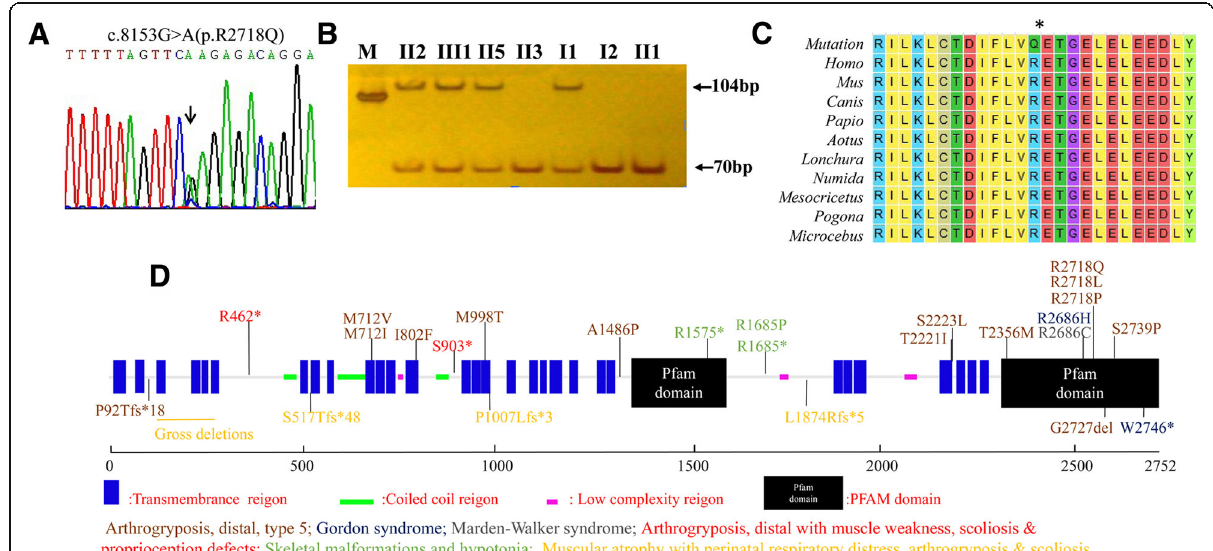
Fig. 4 Identification of a missense mutation in PIEZO2 in affected members of Family 2. a The novel mutation c.8153G > A (p.R2718Q) in PIEZO2 verified by Sanger sequencing. b PCR-RFLP findings with Taq I indicate two DNA fragments in affected patients (II2, III1, II5, and I1; 104 bp and 70 bp) but not in unaffected family members. c Multiple-species sequence alignment shows the evolutionary conservation of position p.R718 in PIEZO2 . d The schematic of PIEZO2 mutation spectrum on functional module. Mutation-related diseases are exhibited in different literal